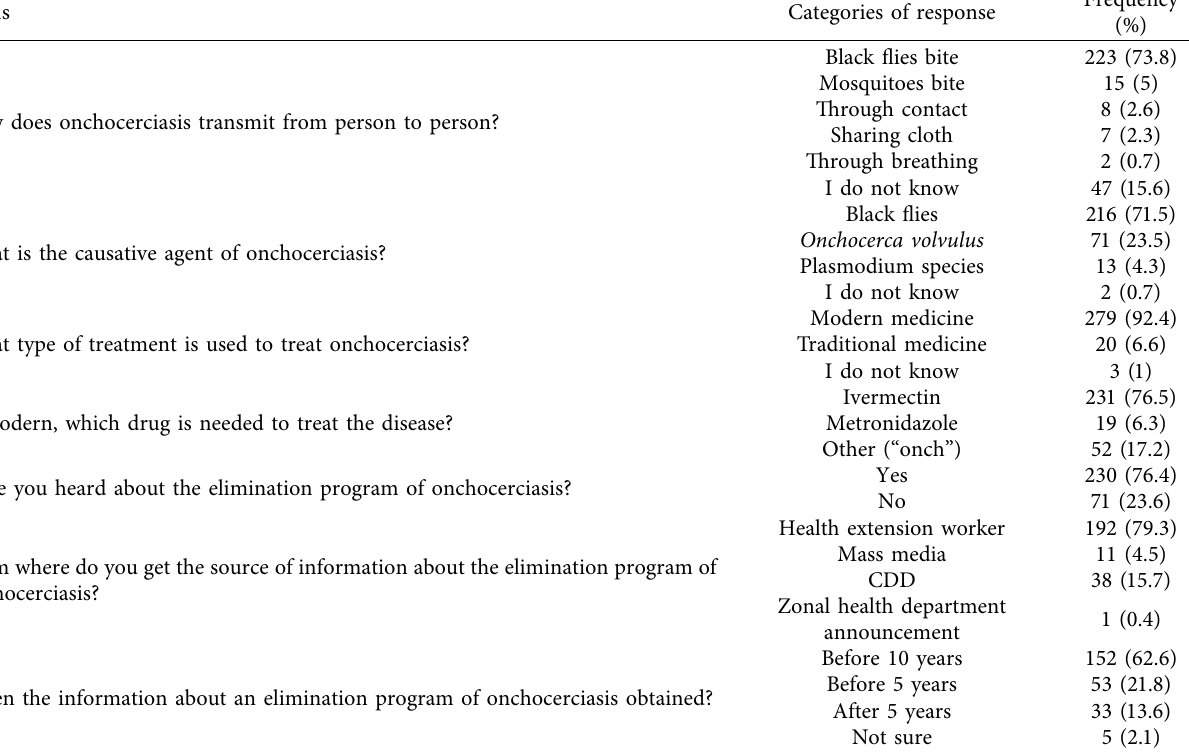
Table 3: Knowledge of respondents on the cause and treatment of onchocerciasis from Gesha town, Ethiopia.